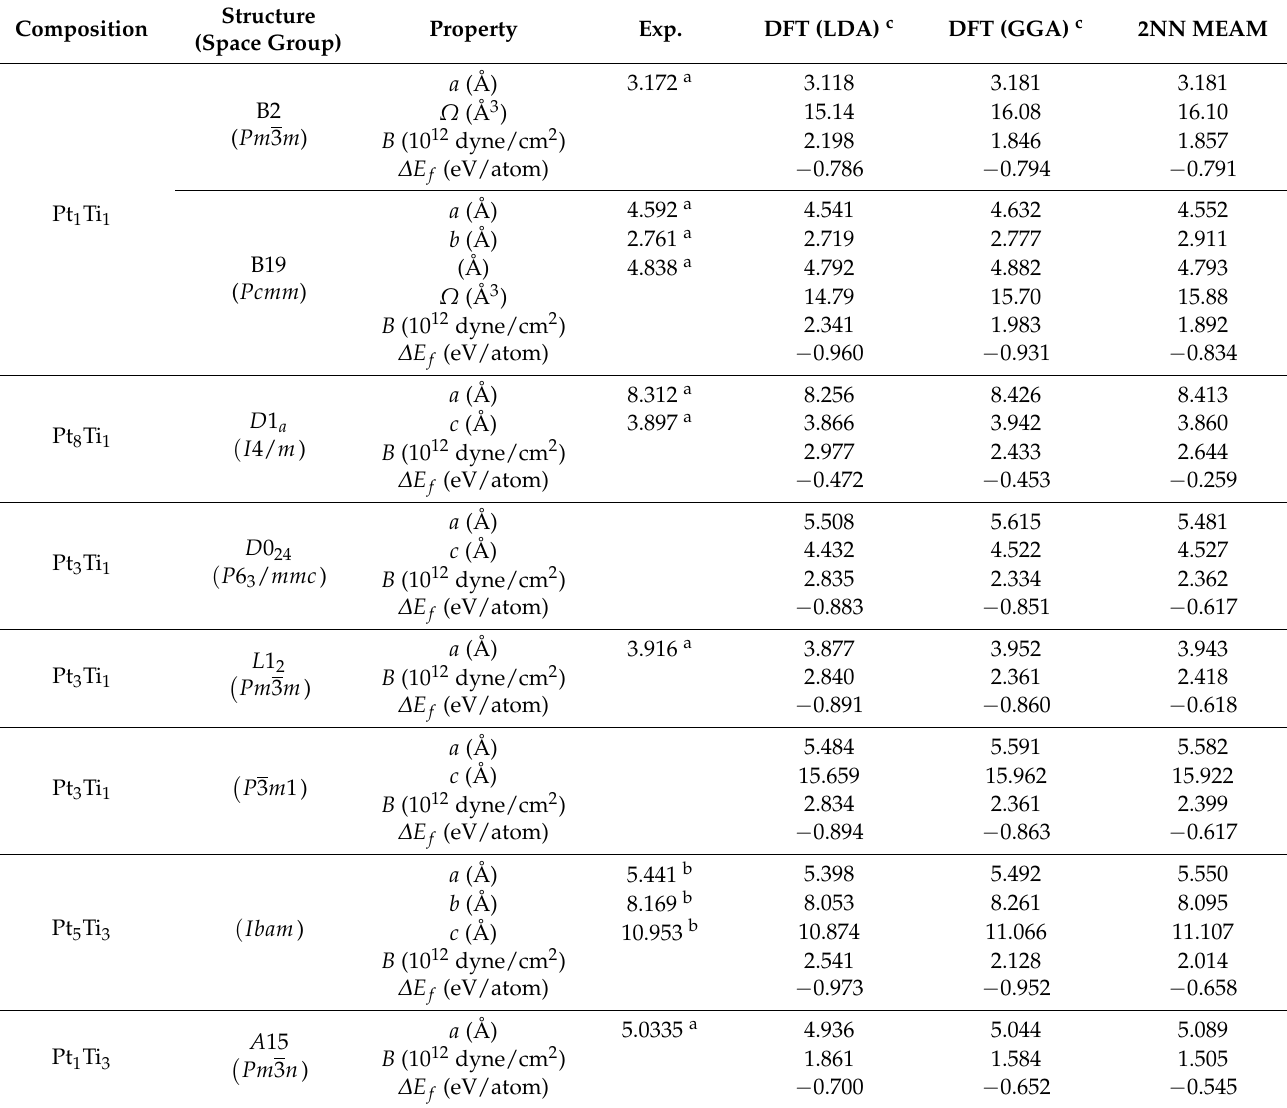
Table 5. Comparison of the physical properties of intermetallic compounds, viz., lattice parameters ( a , b , and c ), atomic volume ( Ω ), bulk modulus ( B ), and enthalpy of formation ( ∆ E f ) obtained from the experiment, present DFT calculation (LDA and GGA), and present interatomic potential. The respective units are provided in the